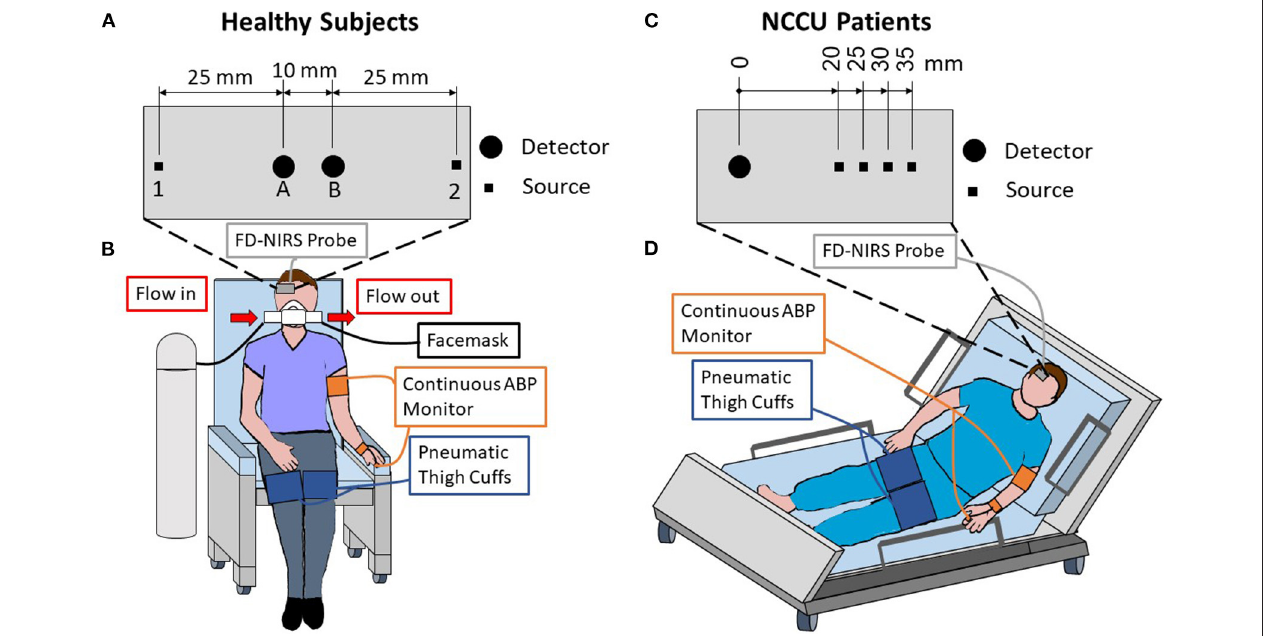
FIGURE 1 | Experimental setup and schematic diagrams of the optical probes used for healthy subjects (A,B) and patients in the neurocritical care unit (NCCU; C,D ). For the healthy subjects, the optical probe was placed on the right side of the forehead and included two sources [1 & 2] and two detectors [A & B] that are symmetrical about the midline of the two sources (A) . The probe featured two single-distance (SD) measurements at 35 mm source-detector distances [1B & 2A], two single-slope (SS) measurements with 25 and 35 mm distances [1AB & 2BA], and one dual-slope (DS) measurement with two 25 mm and two 35 mm distances [1AB2]. For the NCCU patients, the optical probe was placed on the right side of the forehead, it featured four source-detector distances of 20, 25, 30, and 35 mm (C) in a multi-distance configuration. Both setups included an optical probe, finger plethysmograph to monitor arterial blood pressure (ABP), and pneumatic thigh cuffs wrapped around both thighs (B,D) . During the healthy subject experiment (B) , a facemask was worn to breath either medical air or 5% CO 2 mixed with 21 % O 2 and balanced N 2